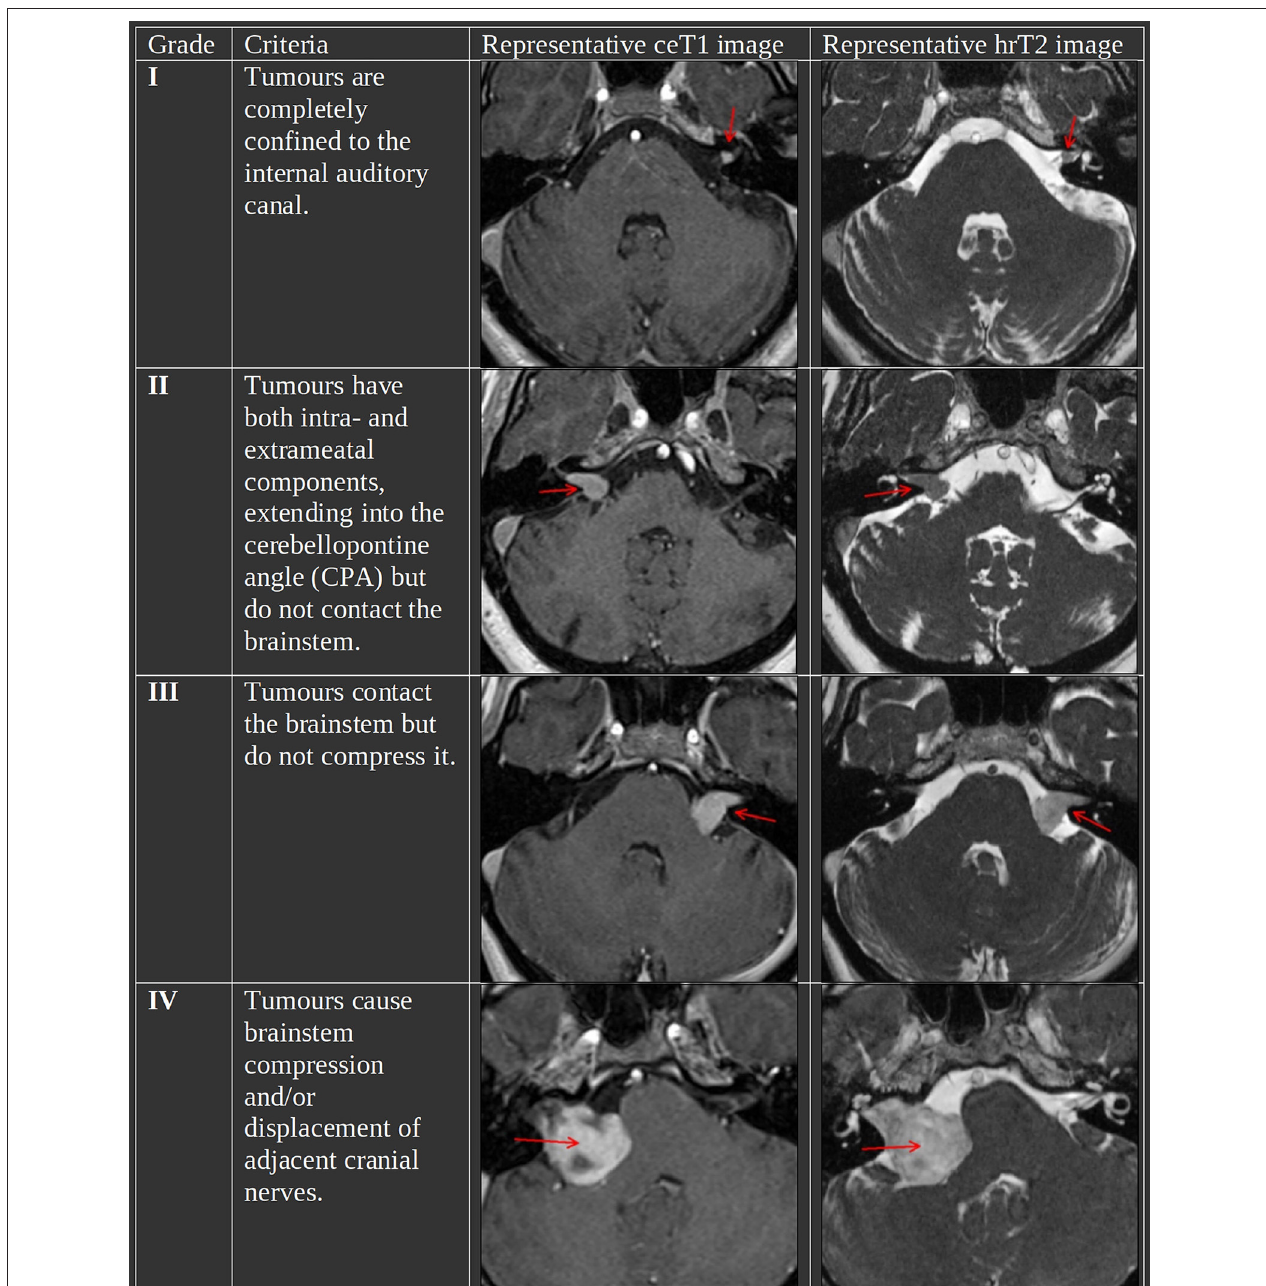
FIGURE 1 | The Koos scale with representative ceT1 and hrT2 images. The images in each row are from the same subject and scan session. Red arrows in the MR images indicate the